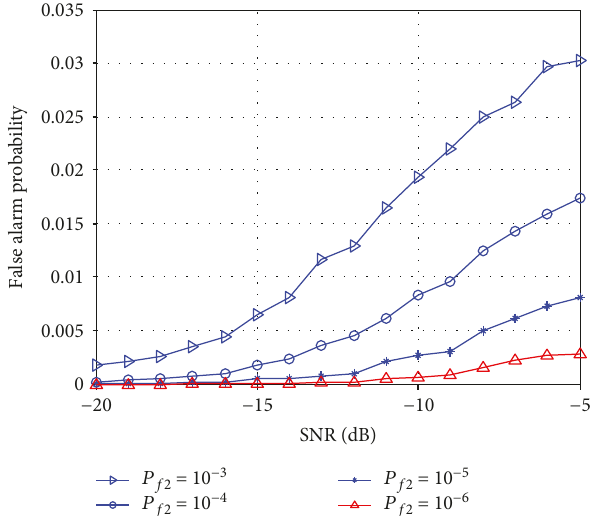
Figure 10: Probability of false alarm detection (signal I).